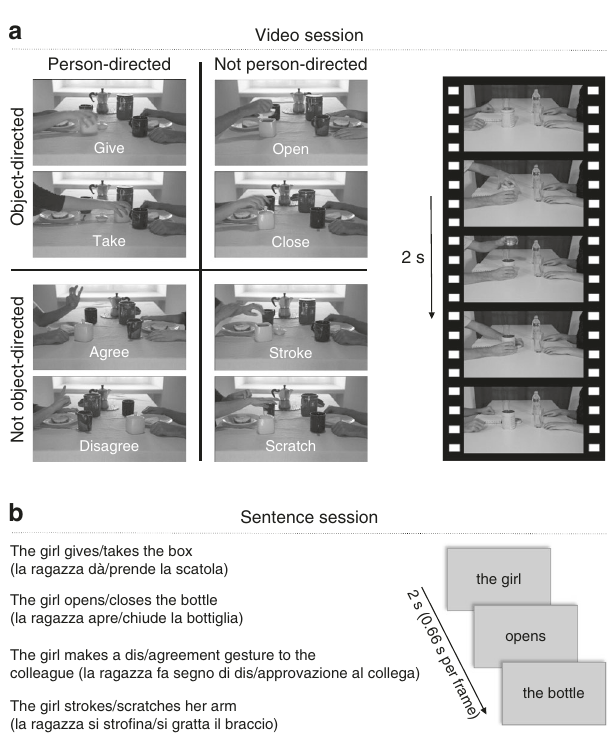
Fig. 1 Experimental design. The video session ( a ) consisted of action videos (8 actions × 24 video exemplars per action, 2 s per video). The sentence session ( b ) consisted of verbal action descriptions corresponding to the actions shown in the videos (8 actions× 24 sentence exemplars per action, 2 s per